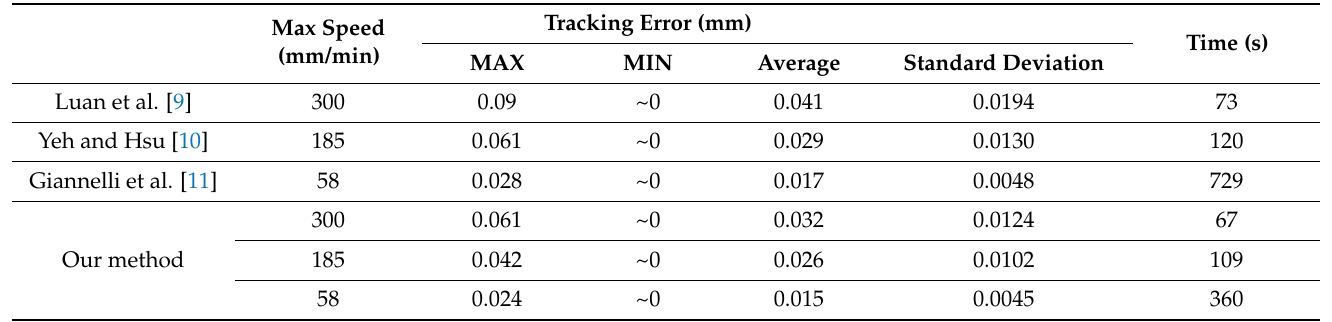
Figure 29. Cutting butterfly shapes using our method with maximum feed rate of 300 mm/min: ( a ) feed rate, ( b ) acceleration, and ( c ) jerk. Table 9. Tracking error and processing time for butterfly shape.